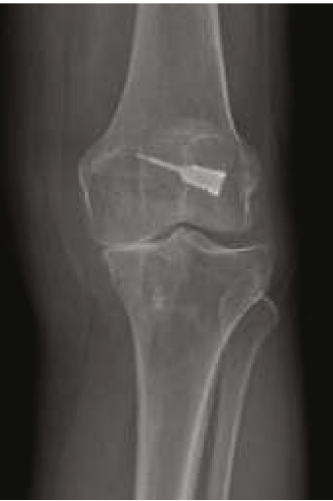
Figure 1: Arthrotek bone mulch ACL screw and WasherLoc. Figure 2: Left knee with signi fi cant medial compartmental osteoarthritis and evidence of a previous bone mulch ACL screw.